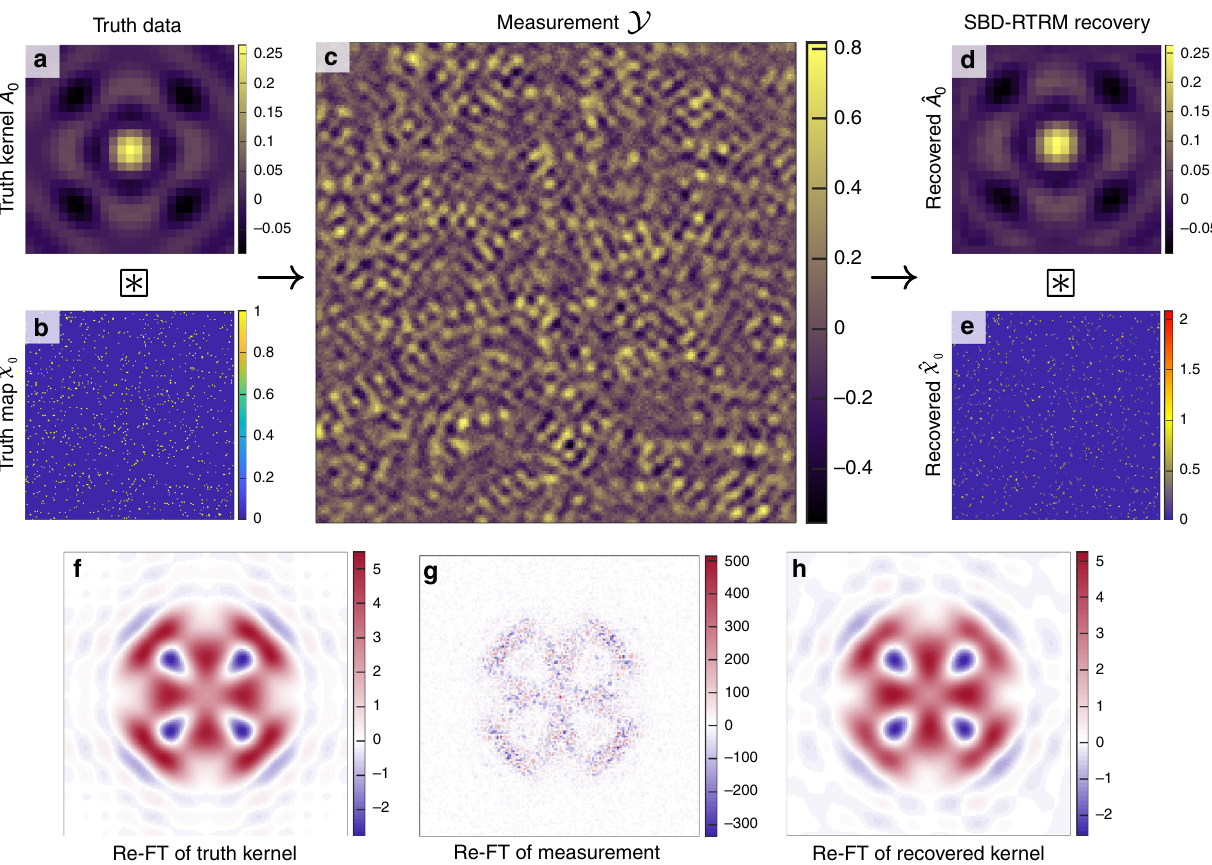
Fig. 3 Illustrating the SBD-STM procedure. The simulated kernel (size 25 × 25 pixels) in a is convolved with the activation map in b and added to random noise with SNR ≈ 0.792 to produce the simulated noisy measurement shown in c . The simulated measurement is a 185 × 185 pixel image with a defect concentration of θ = 2.73%. d Recovered kernel and e recovered activation map obtained using SBD-STM with λ = 0.1, showing excellent agreement with simulation inputs in a , b . The Re-FTs of the truth kernel, noisy measurement, and the recovered kernel from SBD-STM, shown in f – h , respectively. The Re- FT spectra are all shown with − 3 π / 5 a ≤ q x , q y ≤ 3 π / 5 a , and all color bars are in arbitrary units. The SBD-STM-based FT shows both vastly improved SNR and a phase-sensitive recovery of the scattering